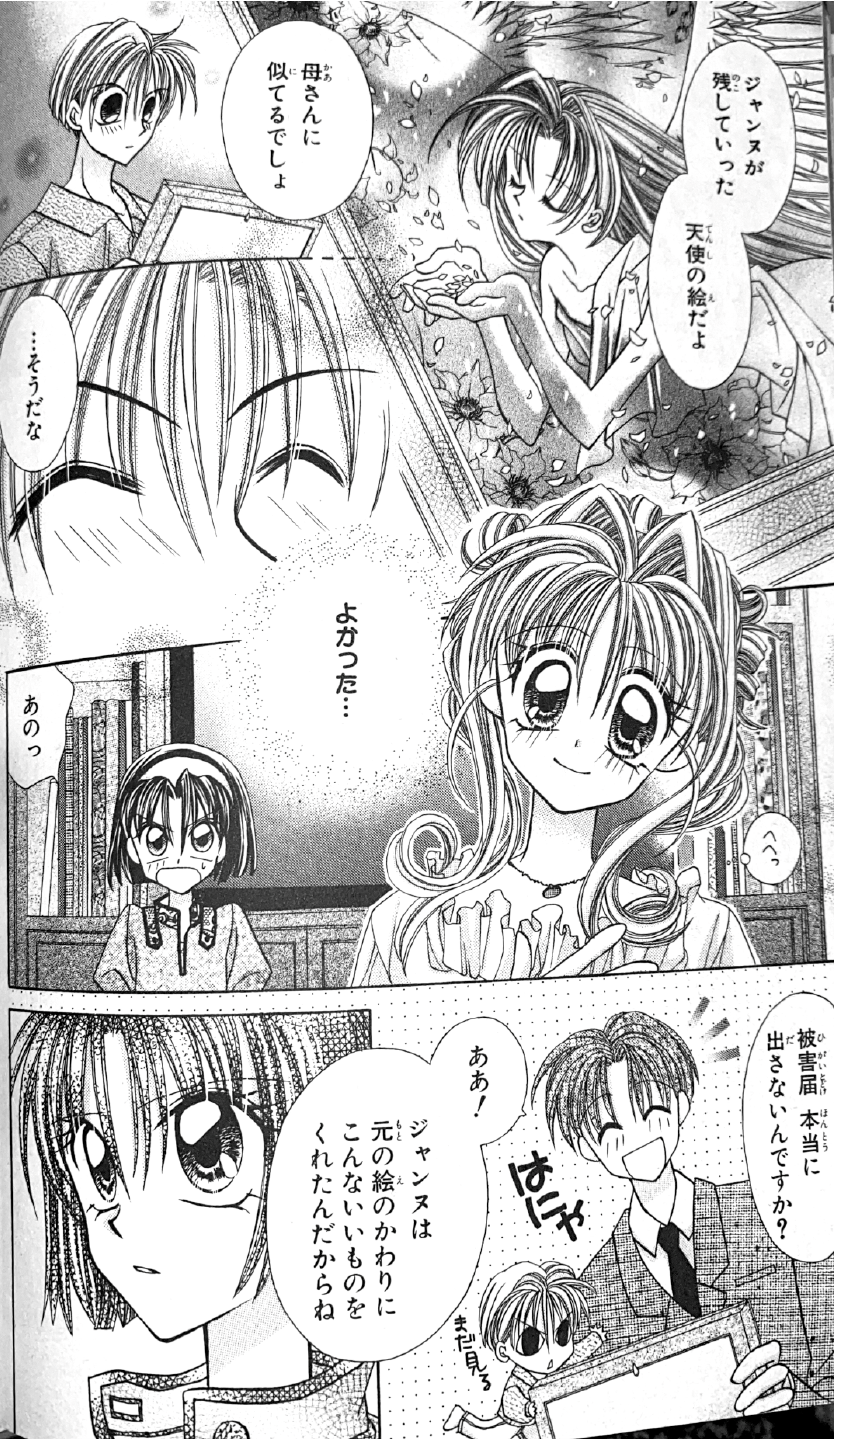
Figure 8 Image that appeared after Jeanne stole a painting and left an image of an angel that resem- bles the mother of the owner of the vanished artwork (complete page) (Tanemura